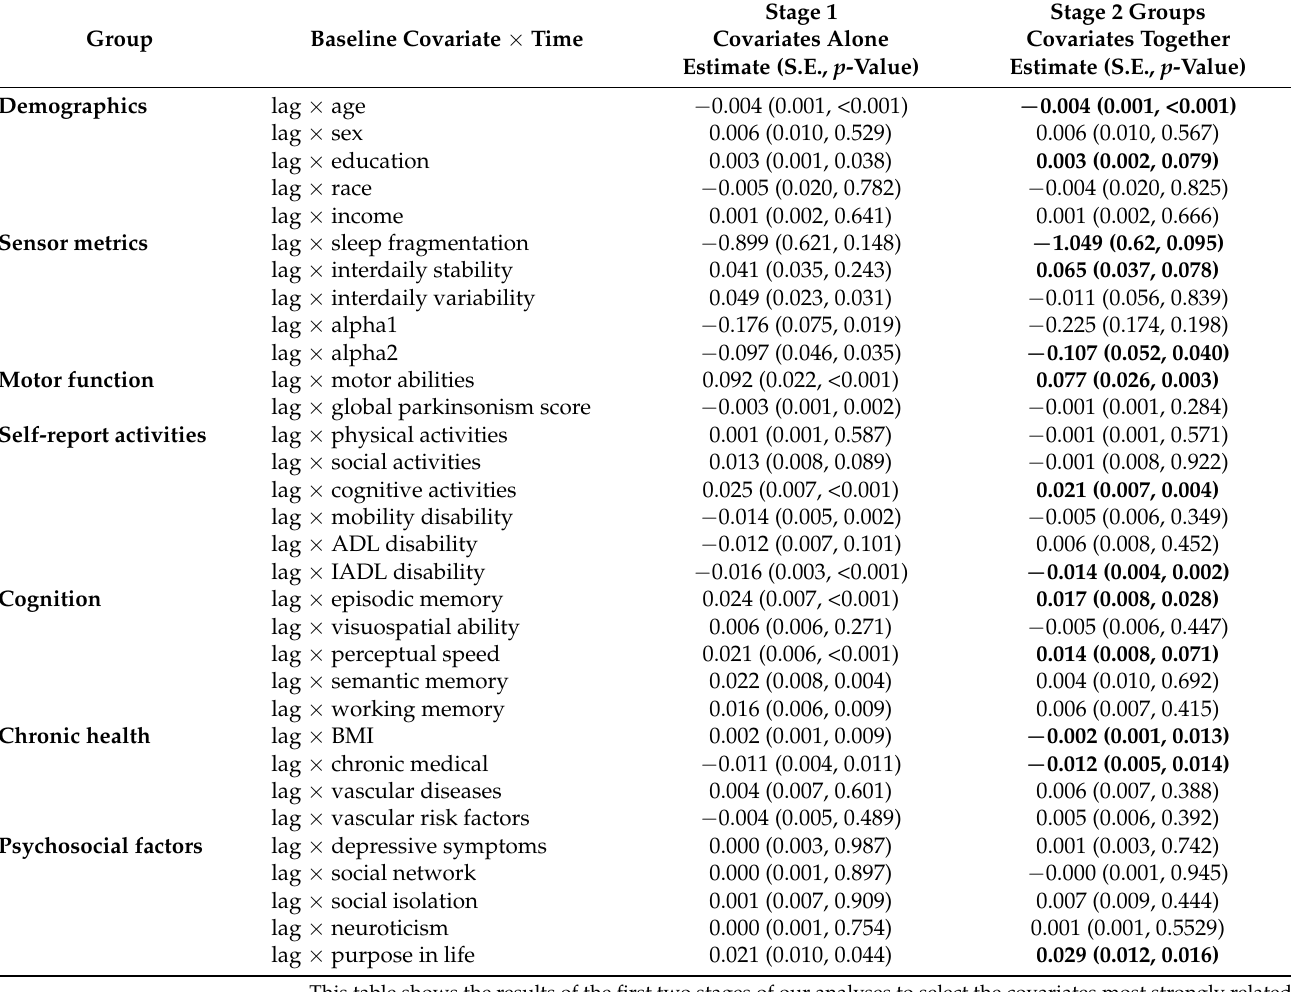
Table 2. Selection of Key Covariates Associated with Declining Total Daily Physical